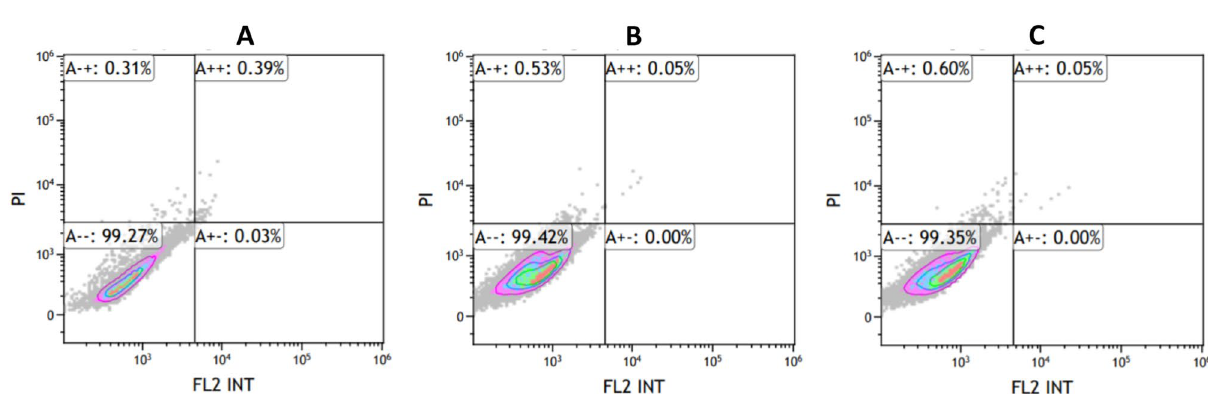
Figure 7. P-gp expression (MDR1) on the HCT116 cells. ( A ) Control, ( B ) Carboplatin, ( C )